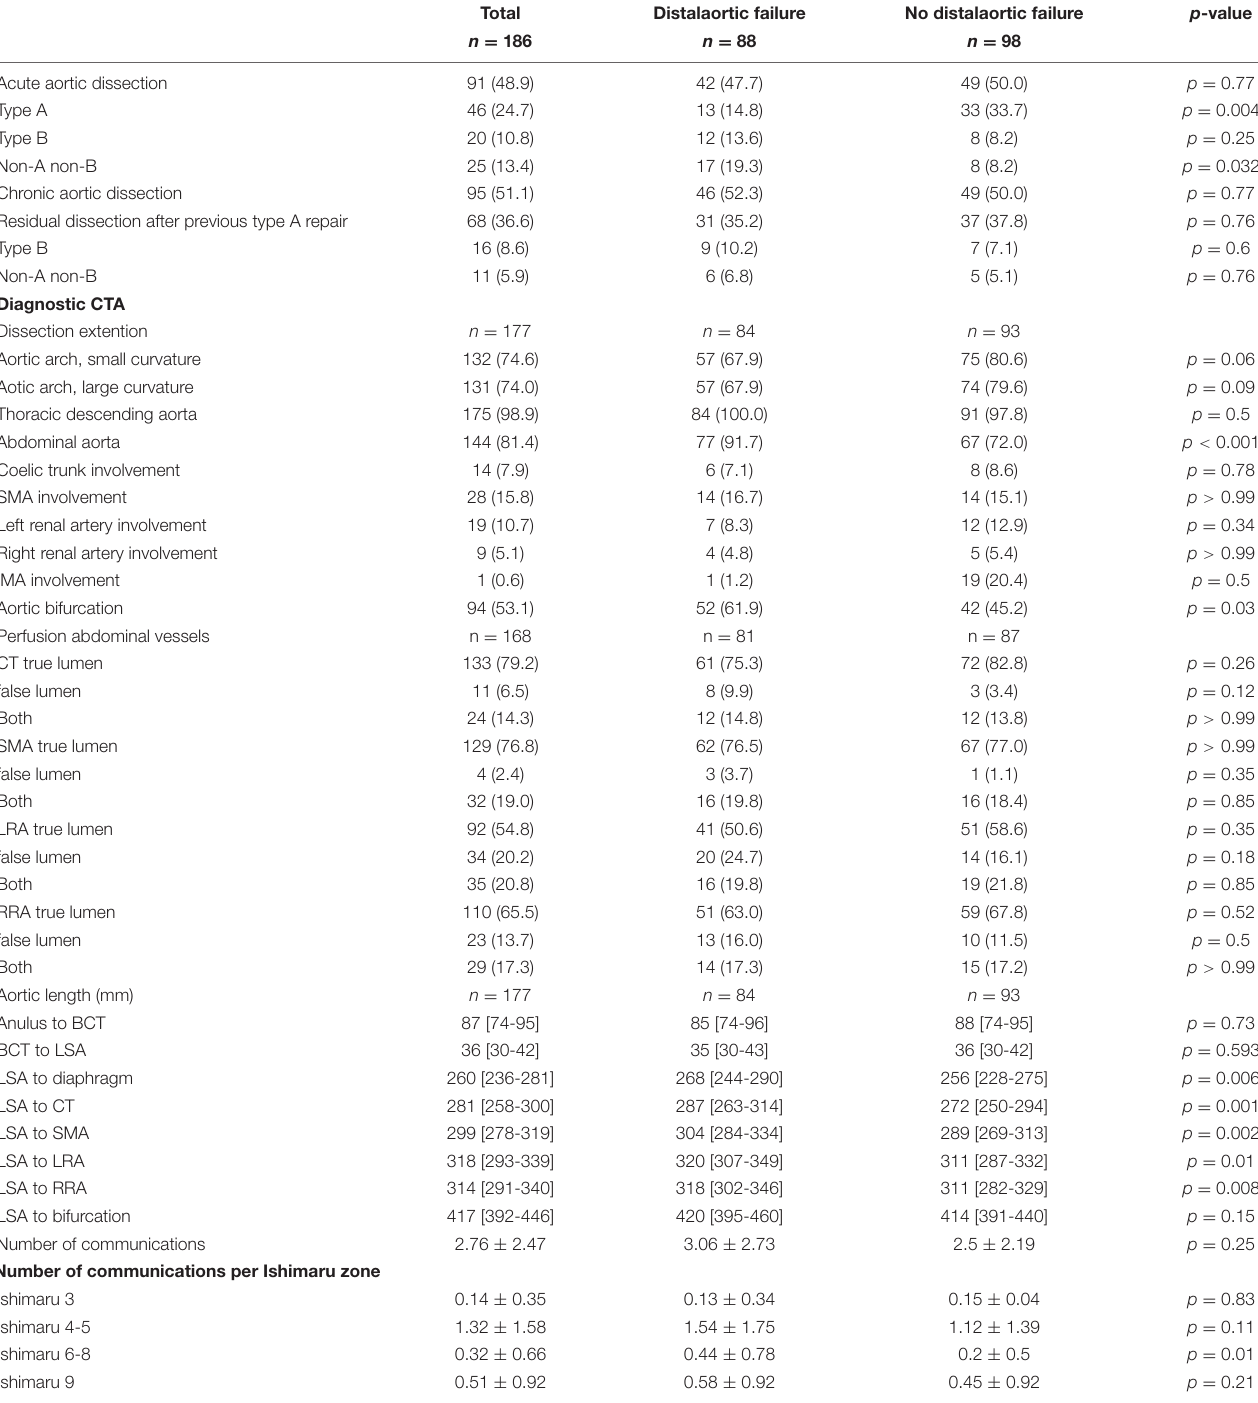
TABLE 2 | Aortic characteristics and measurements (preoperative